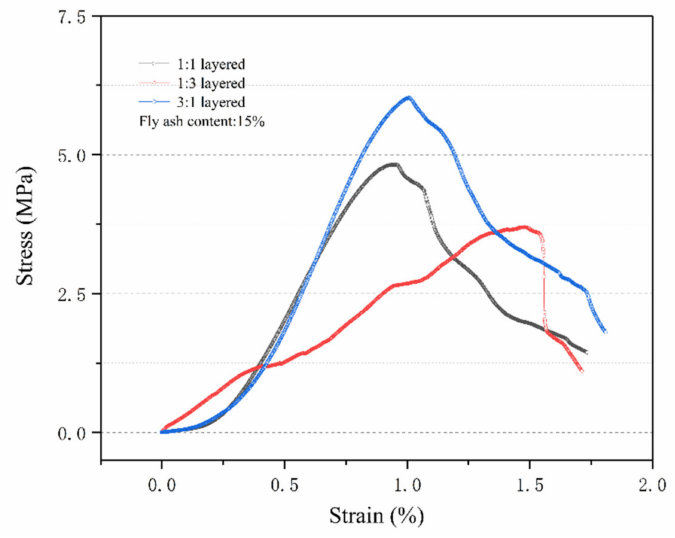
Figure 12. Stress–strain curves of ASPLB with different layering ratios (28